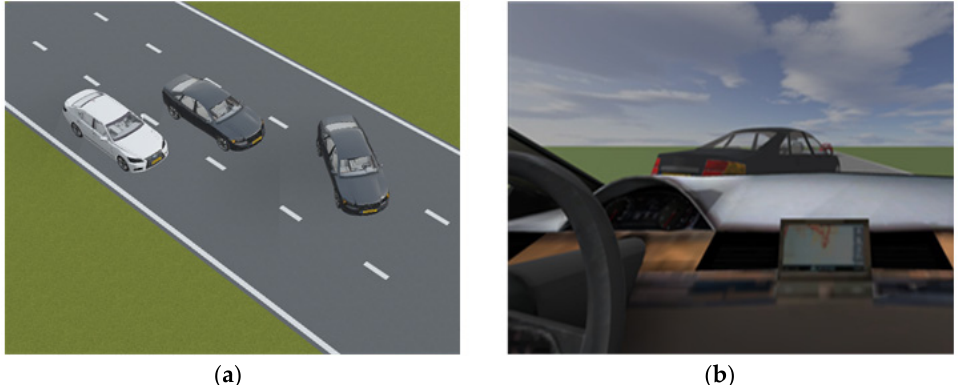
Figure 15. Lane change conflict in the simulation environment from ( a ) top-view and from ( b ) driver’s view.